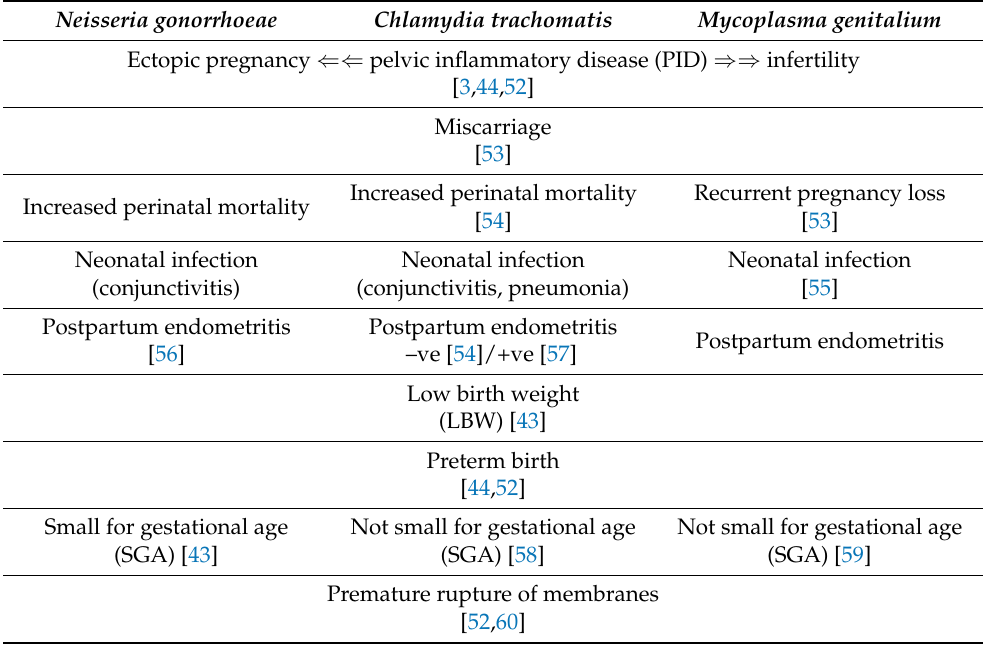
Table 1. Adverse pregnancy outcomes regarding N. gonorrhoeae , C. trachomatis , and M. genitalium